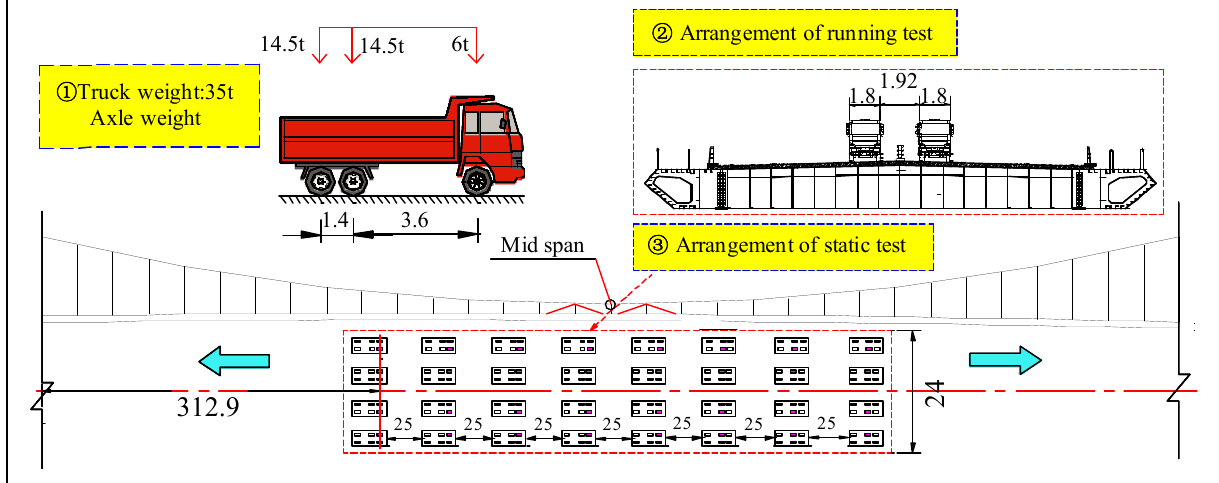
Figure 6. Load case of bridge static and running tests. (unit: m)